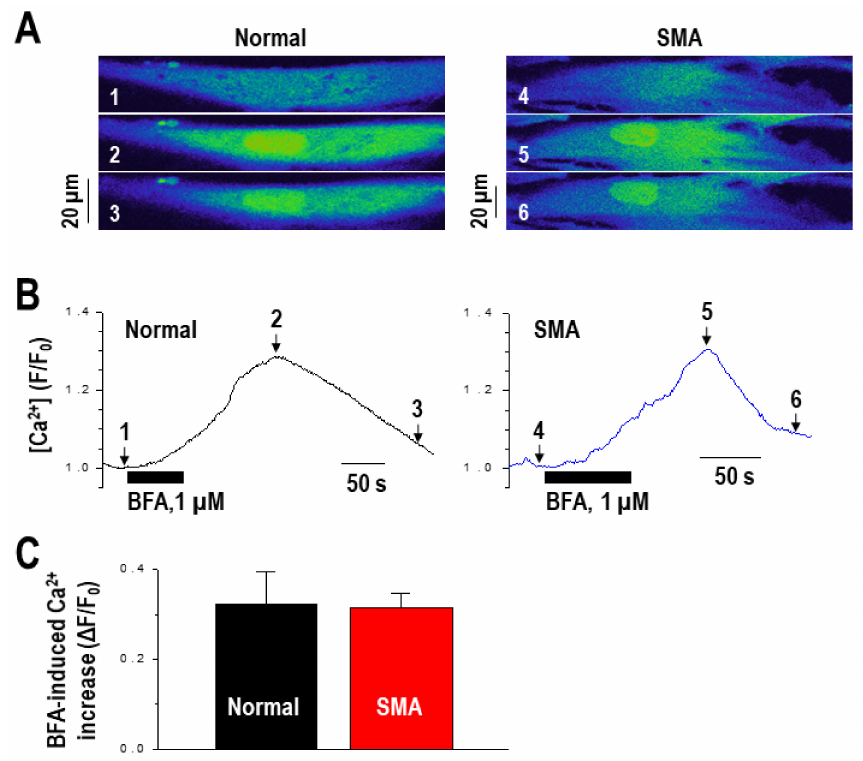
Figure 4. BFA increases the intracellular calcium concentration in normal and SMA fibroblasts. ( A ) Confocal fluo-4-Calcium images, taken in representative fibroblasts from normal and SMA at the time points marked in the panel, are shown. As the color scale of confocal images changes from blue to green and green to yellow tone, the fluorescence signal becomes higher. The images labeled with numbers (“1–6”) were selected at the time marked with the corresponding numbers in the signal traces in panel b. ( B ) Time course of calcium changes by BFA (1 µ M), showing an increase in calcium level (F/F 0 ). ( C ) Averaged calcium increases in normal ( n = 10) and SMA ( n = 24) fibroblasts were not significantly different ( p >